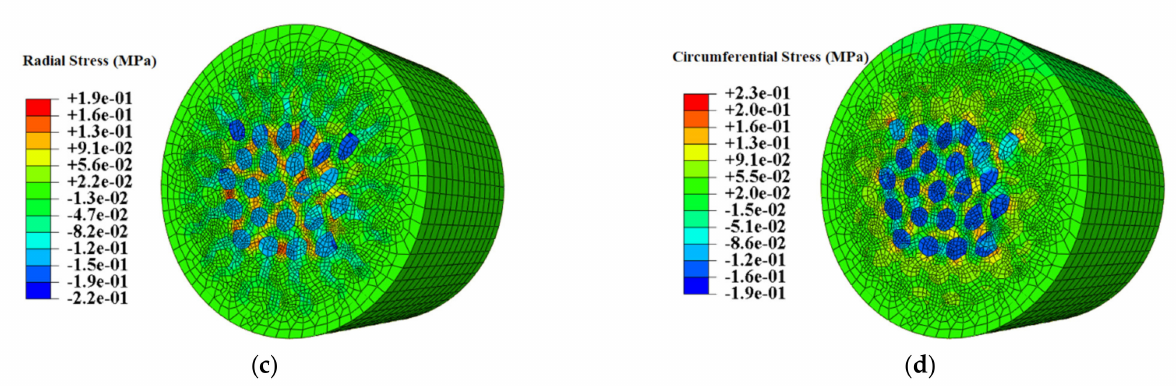
Figure 10. ( a ) Radial and ( b ) circumferential stress distribution and magnitude of ≈ 25%Al-ACCA sample (at ≈ 0.2% strain) ( c ) radial and ( d ) circumferential stress distributino at the end of the numerical tensile test (at 1% strain).